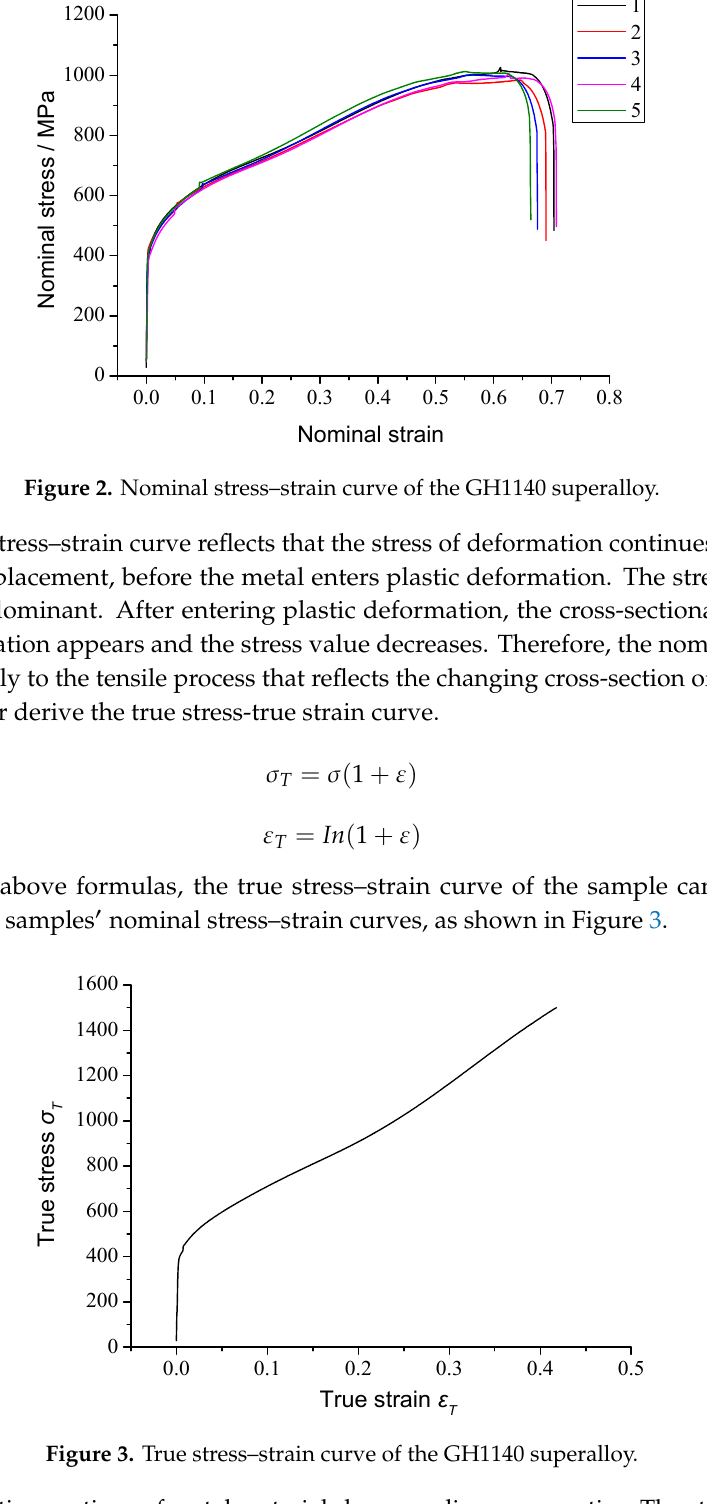
Figure 1. Tensile test sample of the GH1140 superalloy: ( a ) the tensile test sample structure; and ( b ) the stretched test sample.